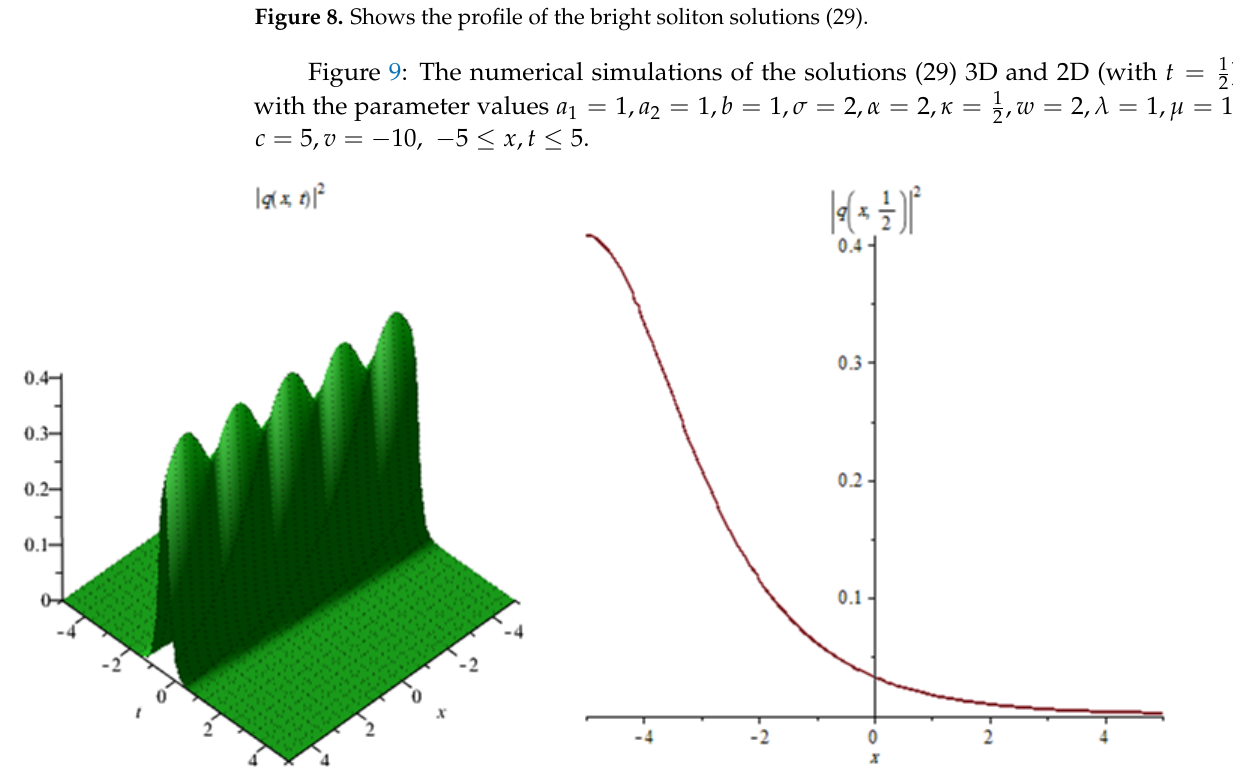
Figure 9. Shows the profile of the bright soliton solutions (29). Figure 10: The numerical simulations of the solutions (51) 3D and 2D (with t = 1 with the parameter values a 1 = 4, a 2 = 2, b = 16, σ = 0, α = 1, κ = 2, w = 10, λ = 2, − µ = 2, c = 10, v = 2, 5 x , t − ≤ ≤